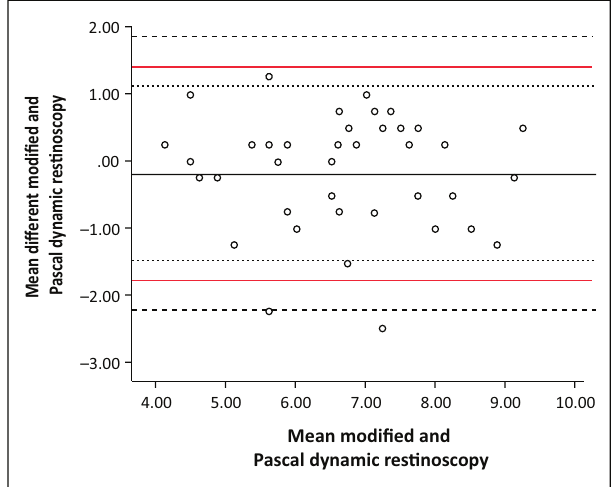
FIGURE 6: A Bland–Altman plot of differences in modified minus Pascal dynamic retinoscopy measurements against the means for paired measurements is indicated, together with confidence intervals on the limits of agreement. There is a good agreement between the measurements from the two methods concerned. The limits of agreement are indicated by the red lines, while the dashed and dotted lines are 0.025 (inner) and 0.975 (outer) confidence